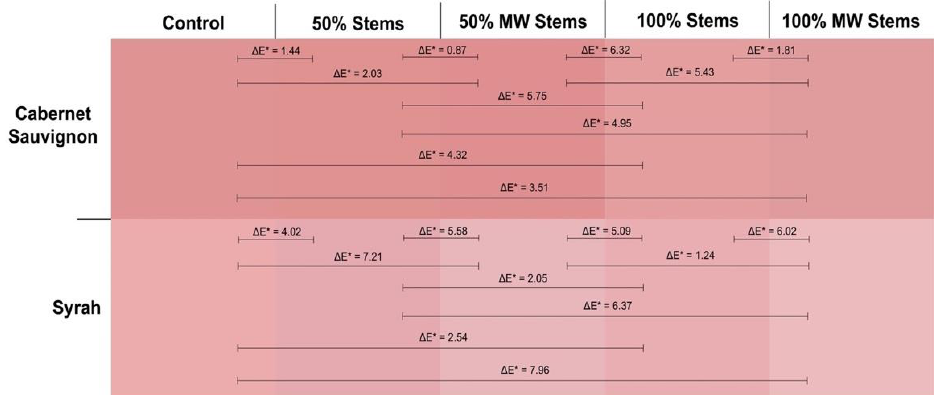
Figure 8. Visual depiction of the actual color of the 2018 wines of the three cvs. and four winemaking treatments as seen through a 1 mm path length quartz cuvette at day 1100 (32 months of bottle aging). ΔE* values are shown between each pair of treatments for a given cv.